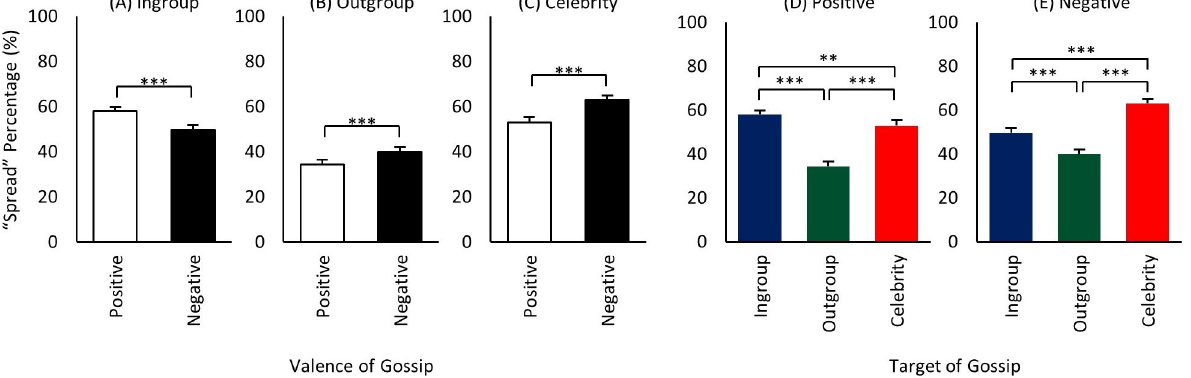
Fig 5. Mean gossip spread rates of 2-way interaction ‘target x valence’. (A) Mean spread rates of positive and negative gossip of ingroup target. (B) Mean spread rates of positive and negative gossip of outgroup target. (C) Mean spread rates of positive and negative gossip of celebrity target. (D) Mean spread rates of positive ingroup, outgroup, and celebrity gossip. (E) Mean spread rates of negative ingroup, outgroup, and celebrity gossip. �� p < 0.01, ��� p < 0.001.